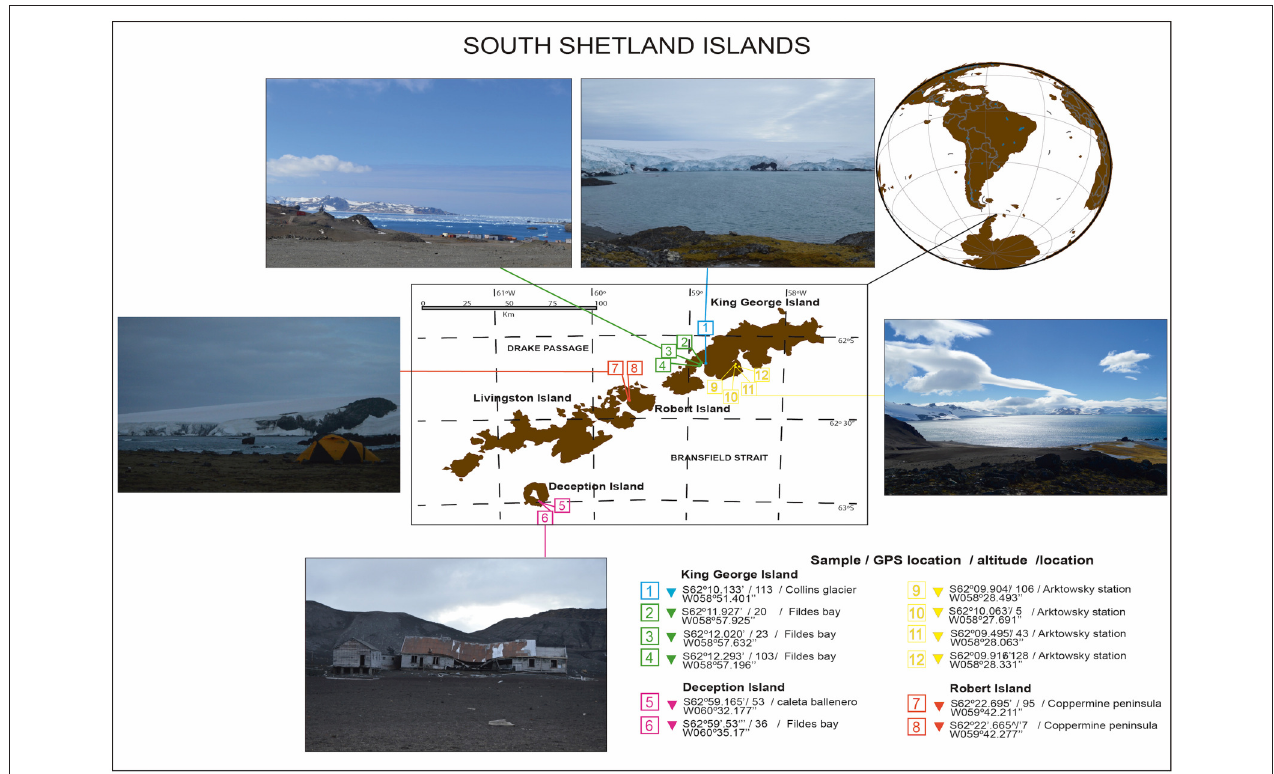
FIGURE 1 | Antarctic soil sampling from the South Shetland Islands during expedition